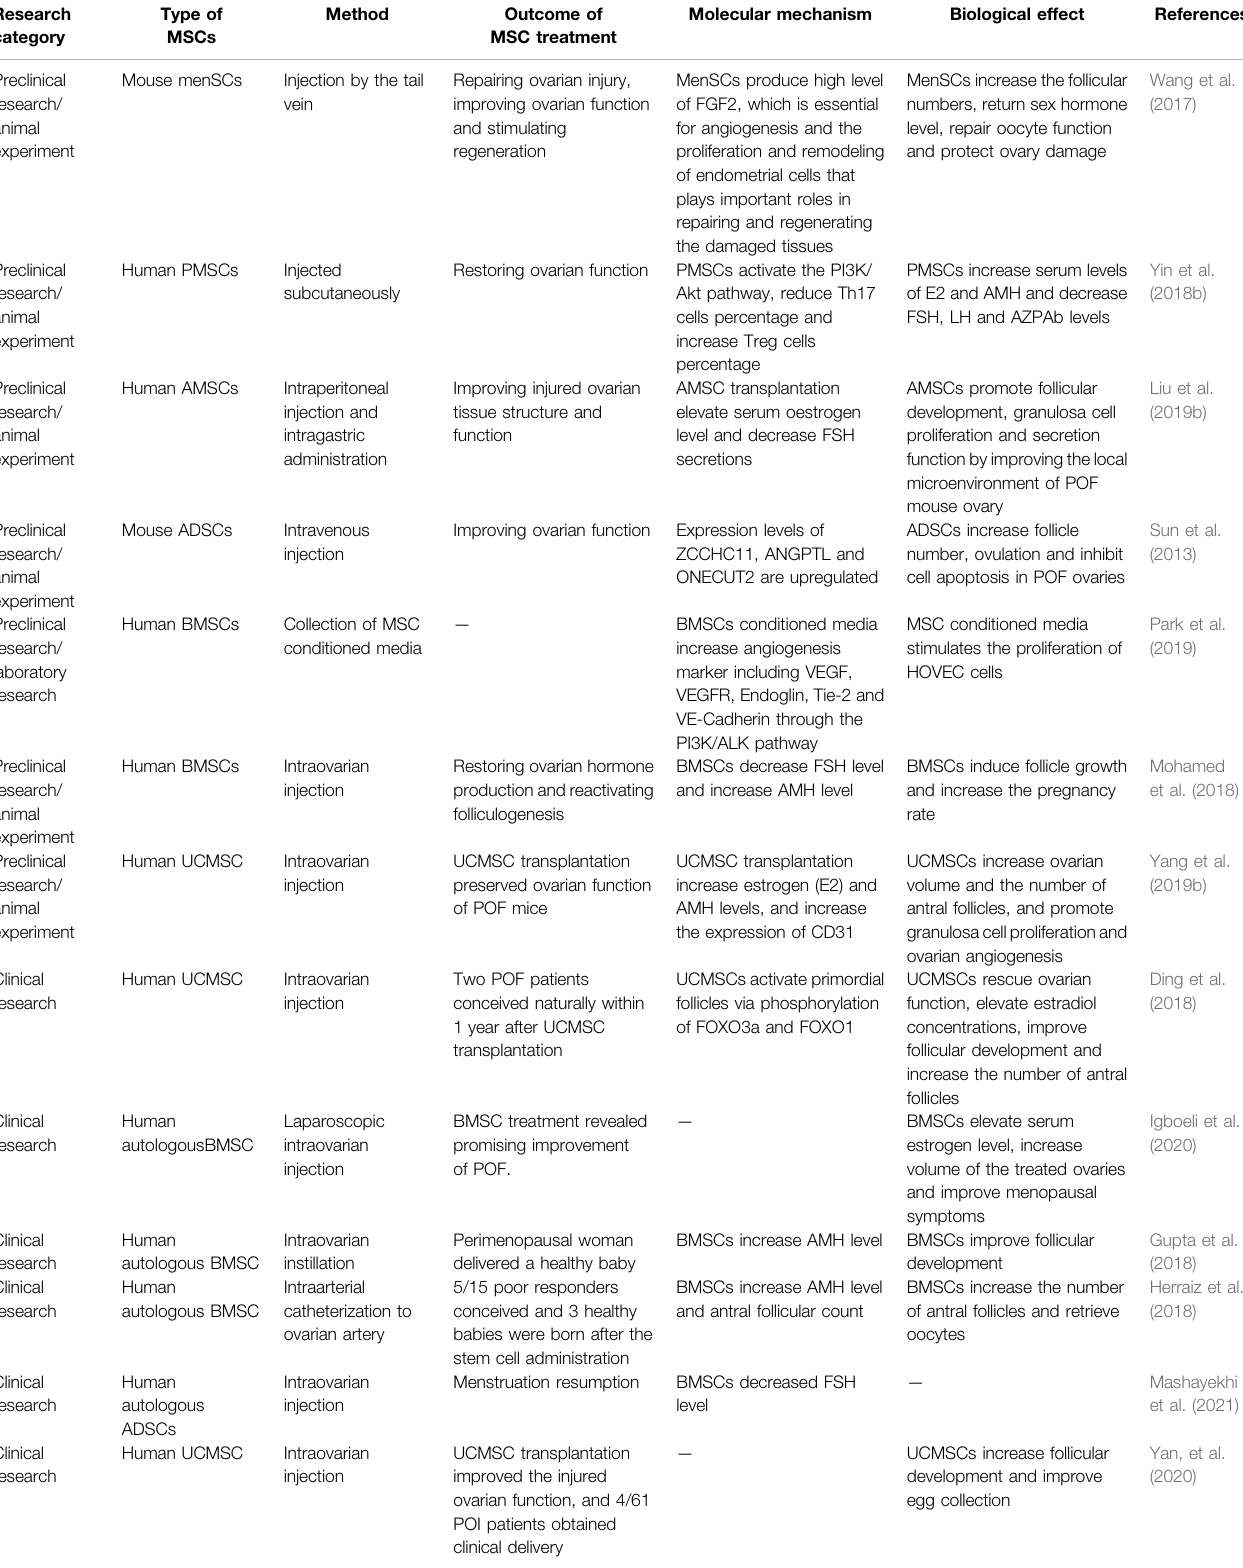
TABLE 1 | Advances in the treatment of POF with